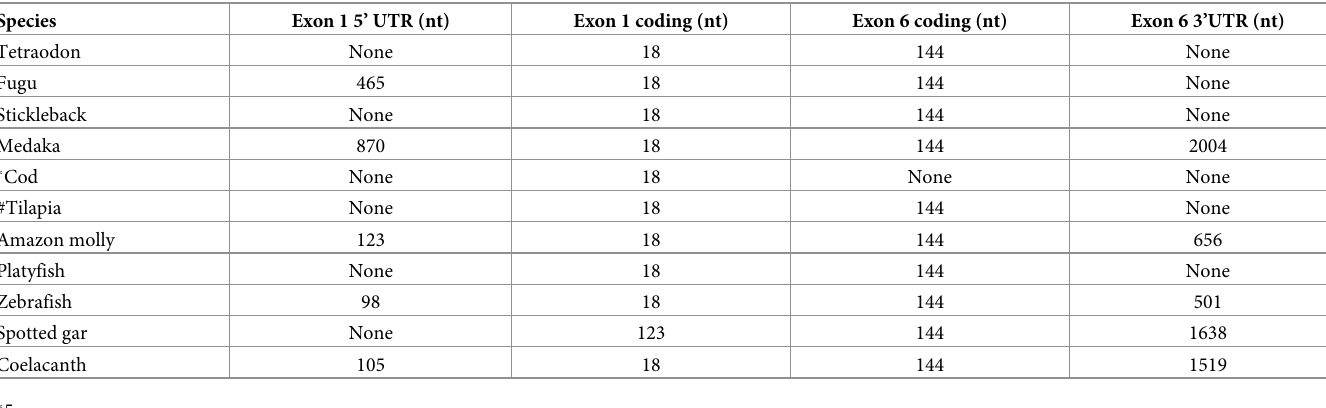
Table 5. Fish Zmat2 genes in